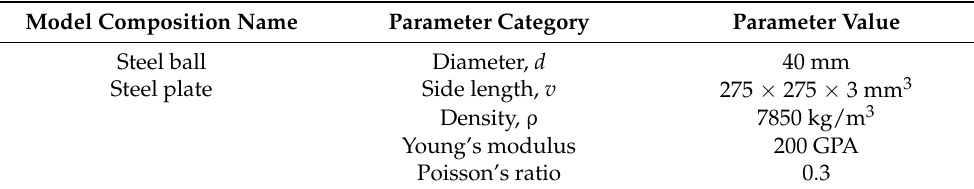
Figure 4. Meshing. Figure 4.